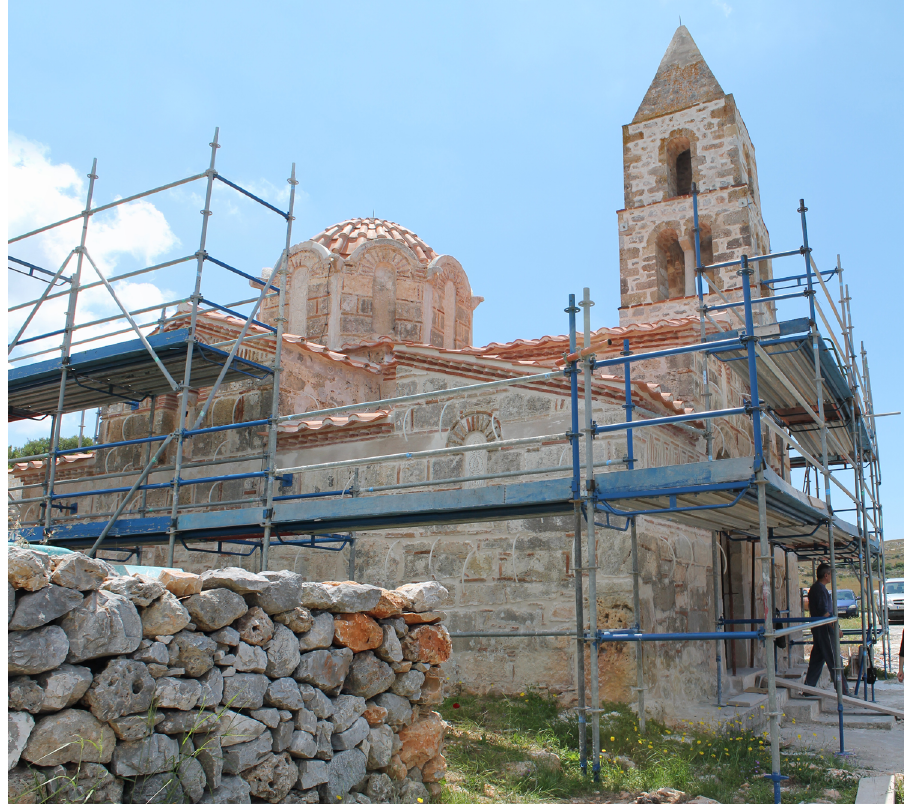
Figure 10. The 12 th -century church of Agios Nikolaos undergoing renovation by the regional archaeological authority (May 2014). The renovation was completed soon after this photo was